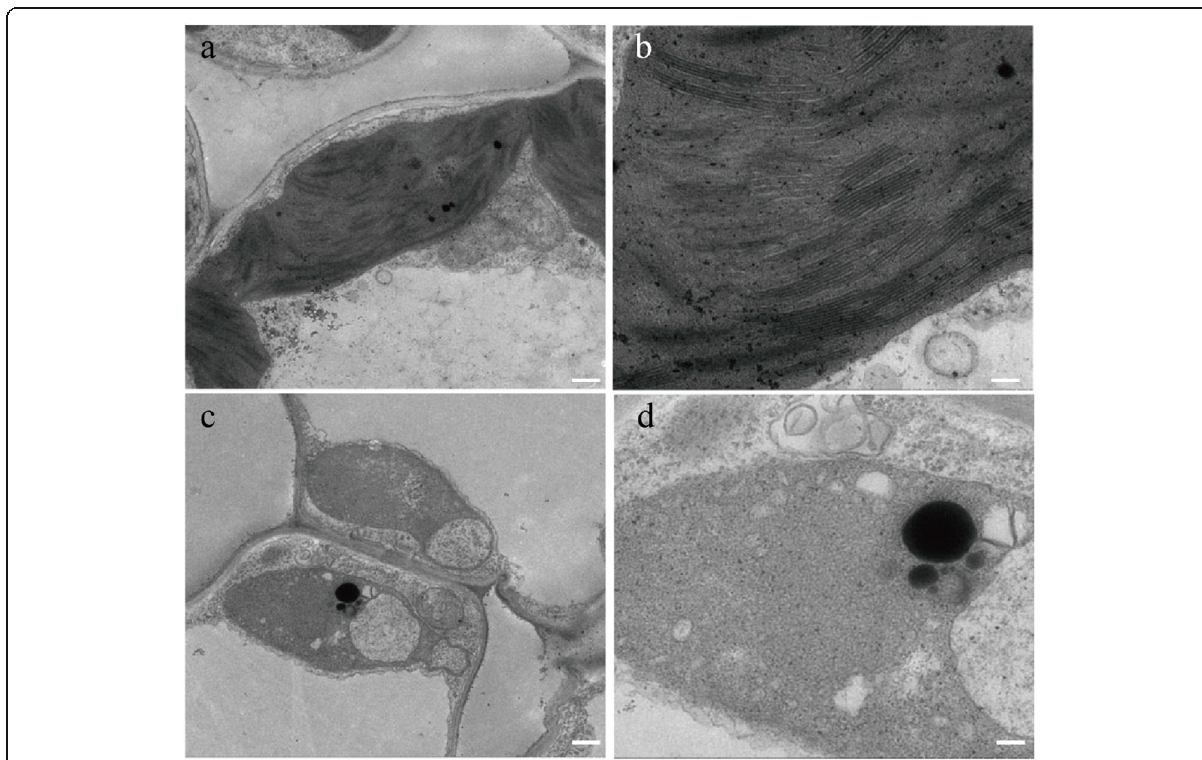
Fig. 2 Transmission electron microscope images of chloroplasts in WT ( a , b ) and wsl9 mutant ( c , d ) seedlings. Scale bar, 0.25 um in a, c; 0.15 um in ( b , d